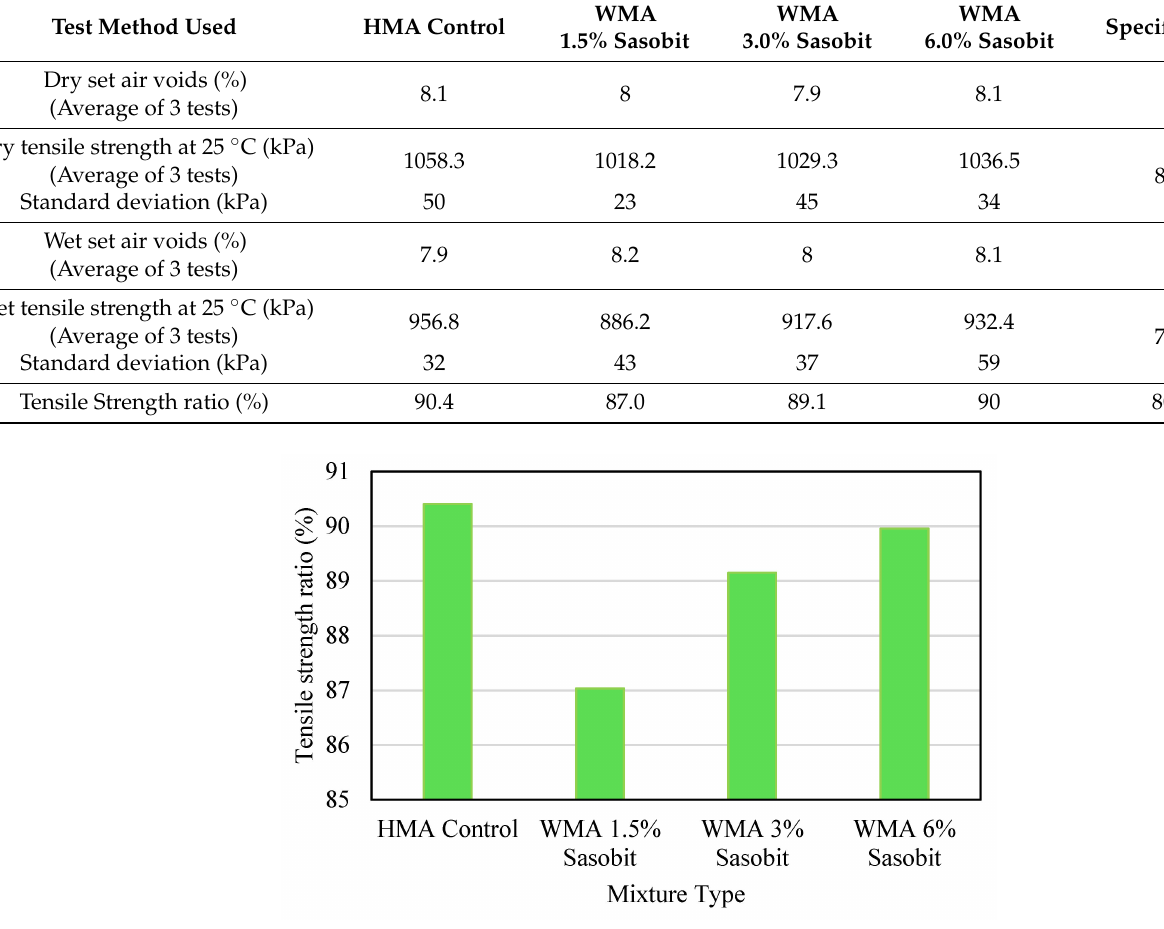
Figure 7. TSR values of different asphalt